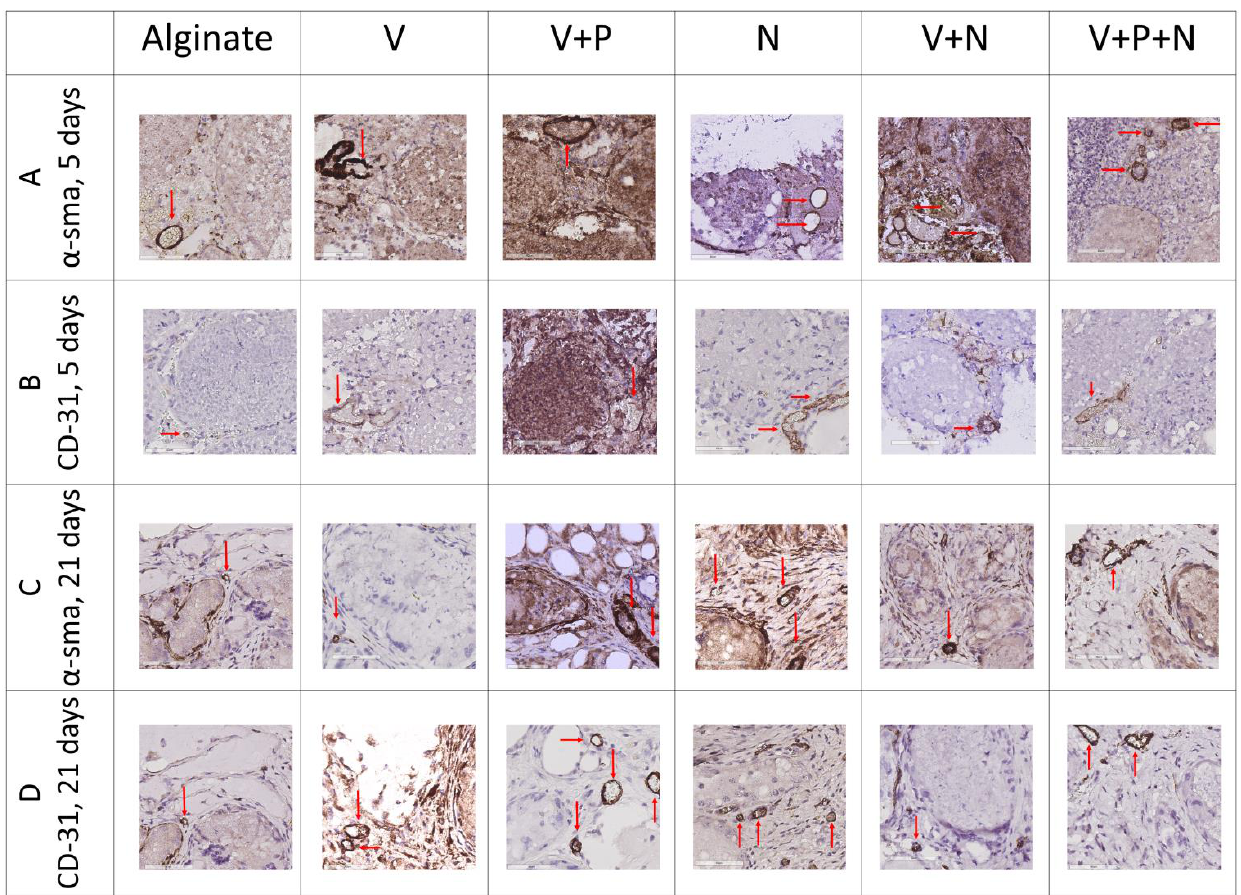
Figure 4. Impact of NP supplementation on the vascularization of mice testicular tissue auto-transplanted for 5 and 21 days. Mouse testicular tissue fragments were encapsulated in alginate supplemented with five different combinations in addition to a negative control (Alginate, V, V+P, N, V+N and V+P+N) and the grafts were stained after 5 and 21 days for α-SMA and CD31. Red arrows highlight positive vascular structures. Scale bar = 60 μm. n = 3.